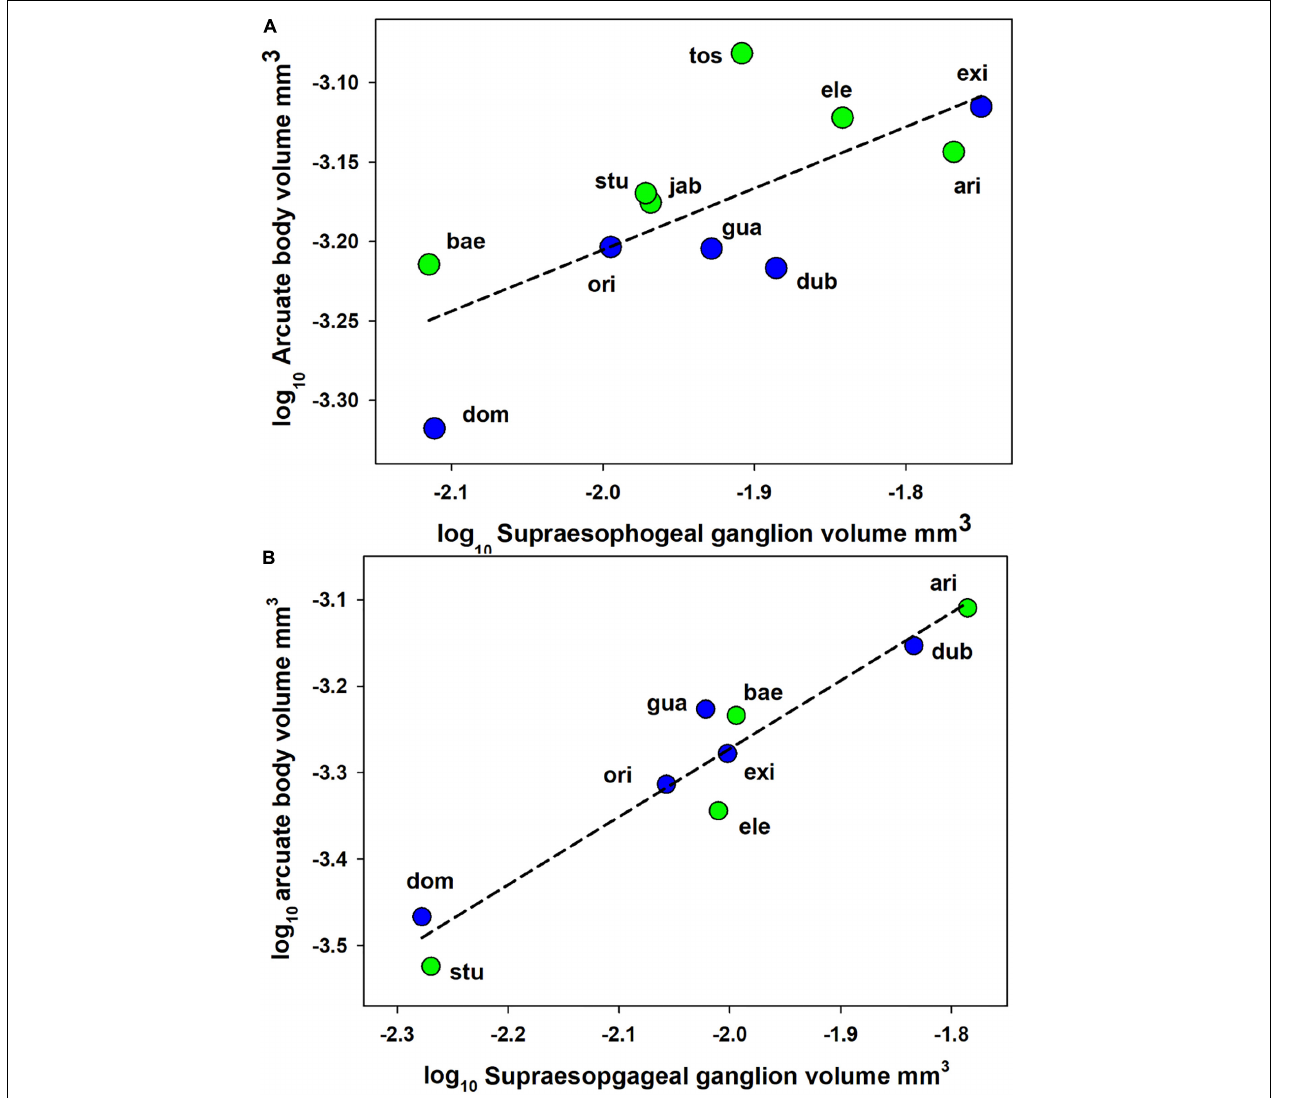
FIGURE 2 | Relationships between log supraesophageal ganglion volume and log arcuate body volume for Anelosimus spiders. (A) Females. (B) Males. Data points represent mean-species values for either social (blue) or subsocial (green) species. Lines represents slopes of linear regression calculated using data from all species. ari A, Arizona ; bae A, baeza ; dom A, domingo; dub A, dubiosus ; ele A, elegans ; exi A, eximius ; gua A, guacamayos ; jab A, jabaquara ; ori A,oritoyacu ; stu A, studiosus ; tos A, tosum .